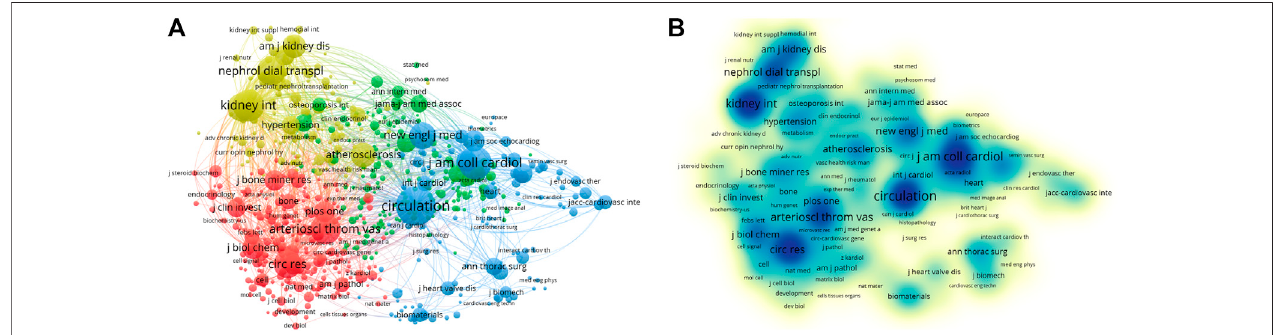
FIGURE 4 | VOSviewer visualization map of most commonly cited journals related to vascular calci fi cation research. (A) Co-citation network of journals. Of the 12,149 most commonly cited journals, 99 had published at least 500 studies. (B) The density map of the most commonly cited journals. The dark blue nodes represent journals with large numbers of citations.